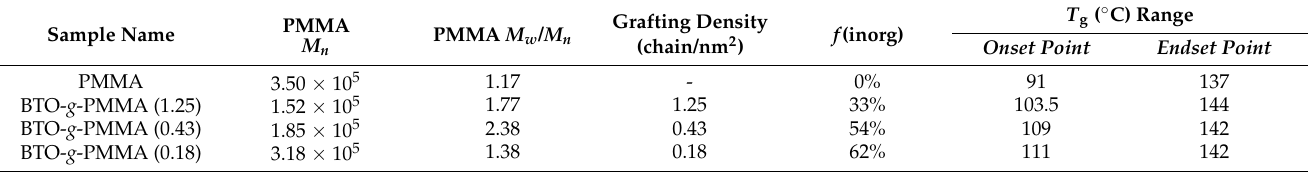
Table 1. Sample specification of PMMA and core–shell BTO- g -PMMA composites based on barium titanate core of 200 nm size; ( f inorg = percentage of inorganic